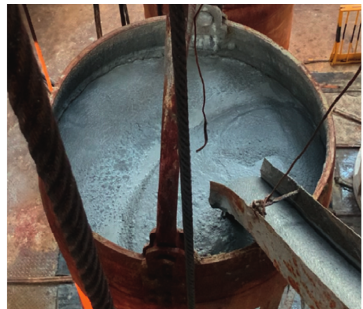
Figure 3: HPC after mixing.